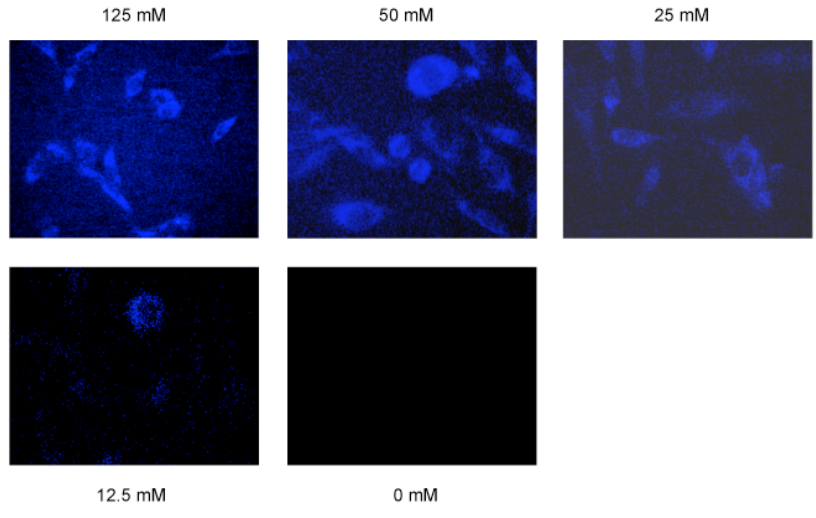
Figure 3. 8-Azido cAMP was detected by cycloaddition reaction with various concentration of